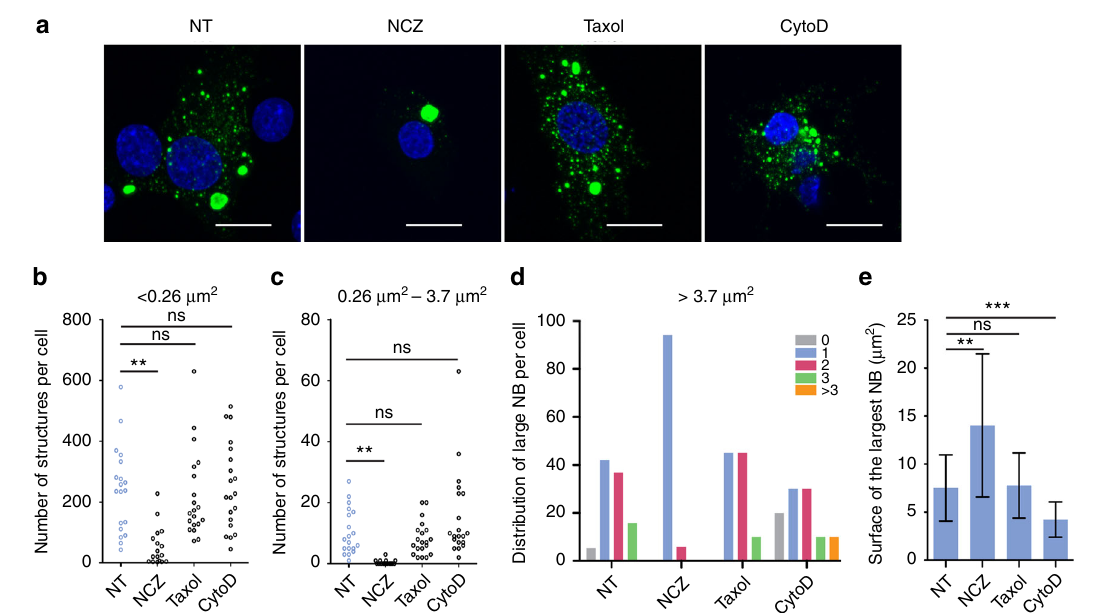
Fig. 4 Effect of cytoskeleton-disrupting drugs on formation and evolution of NBs. Nocodazole (NCZ, 2 µ M), Taxol (1.25 nM) and Cytochalasin D (Cyto D, 2.5 µ M) were added 1 h before and kept all along infection. BSR cells were infected with CVS strain at a MOI of 0.5 and fi xed at 16 h p.i. NT: non treated cells. a Confocal analysis was performed after staining with a mouse monoclonal anti-N antibody followed by incubation with Alexa-488 donkey anti-mouse IgG. DAPI was used to stain the nuclei. Scale bars correspond to 15 µ m. b – d Quanti fi cation of cytoplasmic structures labeled with anti-N antibody in treated and non-treated cells. The number of small dots (surface < 0.26 µ m 2 ) b , of intermediate inclusions (surface between 0.26 and 3.7 µ m 2 ) c , and of large inclusions (surface > 3.7 µ m 2 ) d per cell was quanti fi ed using the image toolbox of MatLab software as described in the experimental procedures. ** p < 0.01, ns: not signi fi cant ( n = 20, two tailed Mann Whitney U test). e Average surface of the largest inclusion in the cell 16 h p.i. in non-treated and treated cells. Areas of inclusions were determined using the image toolbox of MatLab software as described in the experimental procedures. The mean is shown with error bars representing the SD. ns: not signi fi cant; ** p < 2.10 − 3 ; *** p < 10 − 3 ( n = 20, two tailed Welch ’ s t